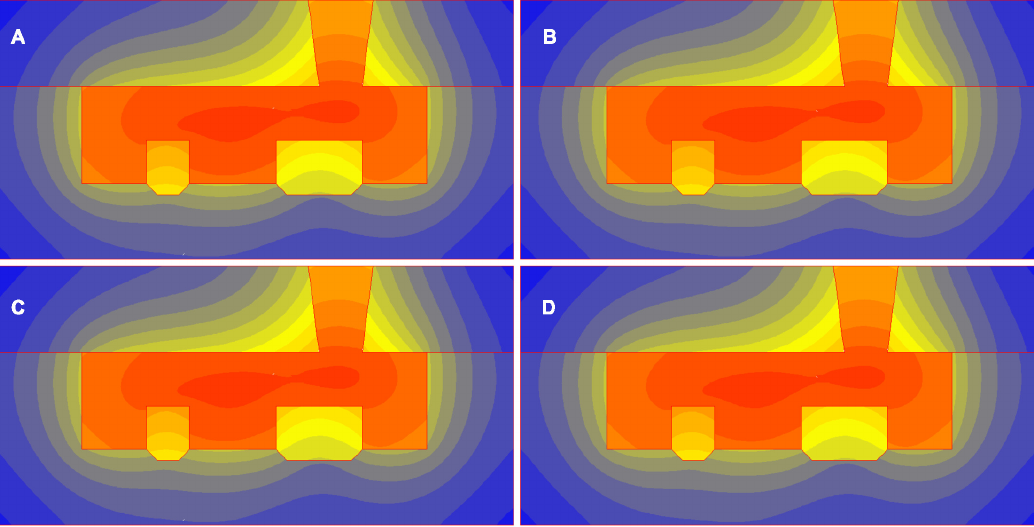
Figure 15. Temperature field in whole domain (a shade of red color—the highest temperature, connected with the cast and a blue color—the lowest temperature) . Four combination of the